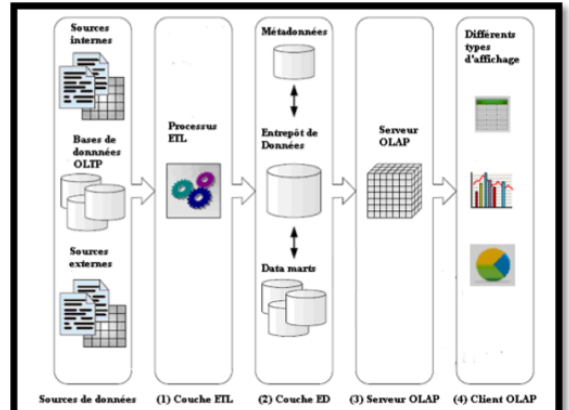
Figure 2: typical architecture of an OLAP system. Adapted from.